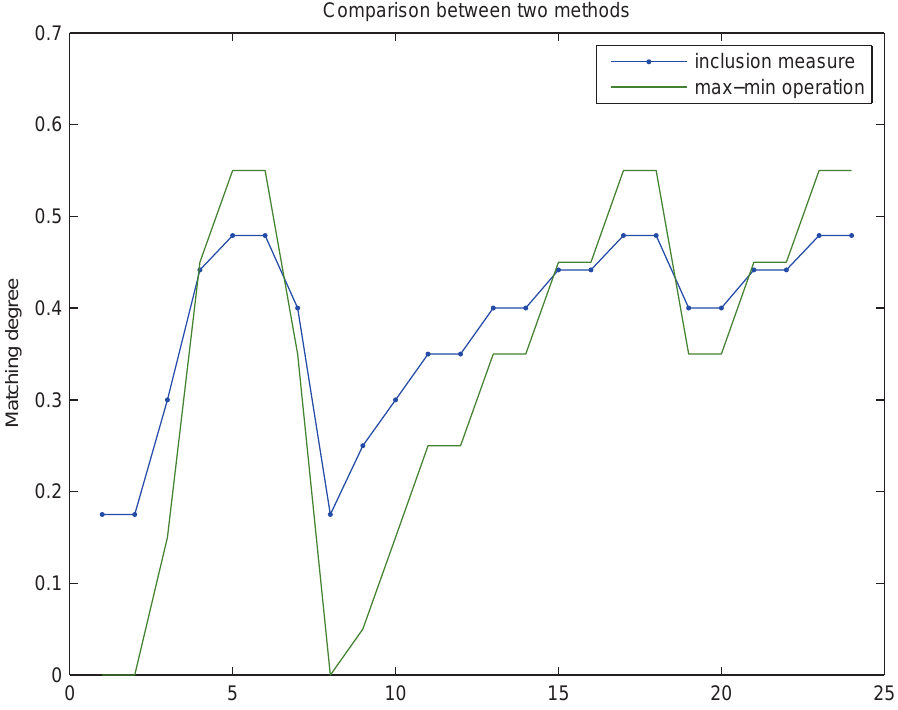
Fig. 3. The matching degree comparison between two methods (inclusion measure and max-min operation) with the changed membership of the third attribute (muscle strength) in the flaccid paralysis